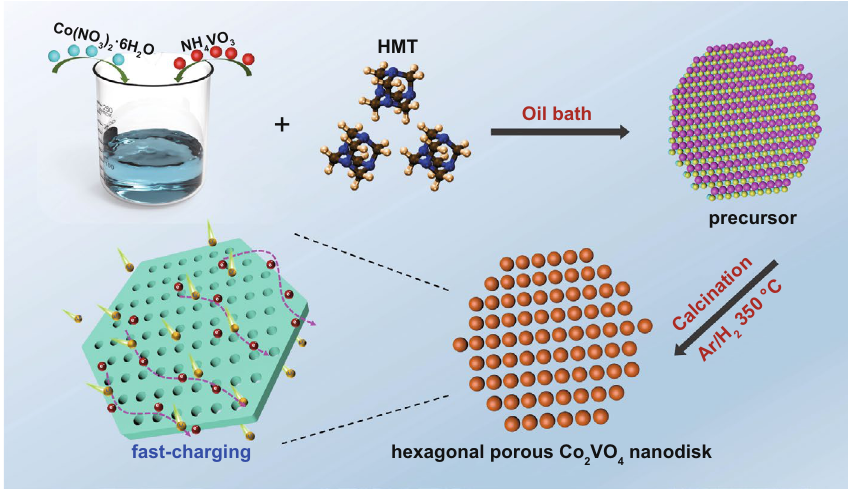
Fig. 1 Schematic illustration of PCVO ND